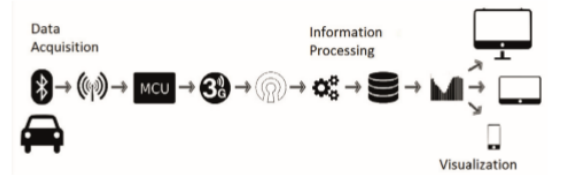
Figure 2: OnDynamic system diagram [14]